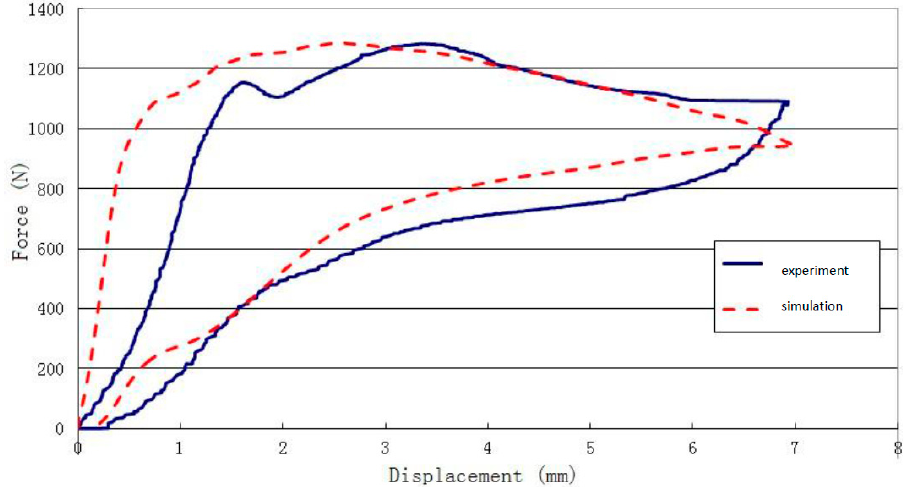
Figure 7. Comparison of the force–displacement curves of the quasi-static experiment and numerical analysis.